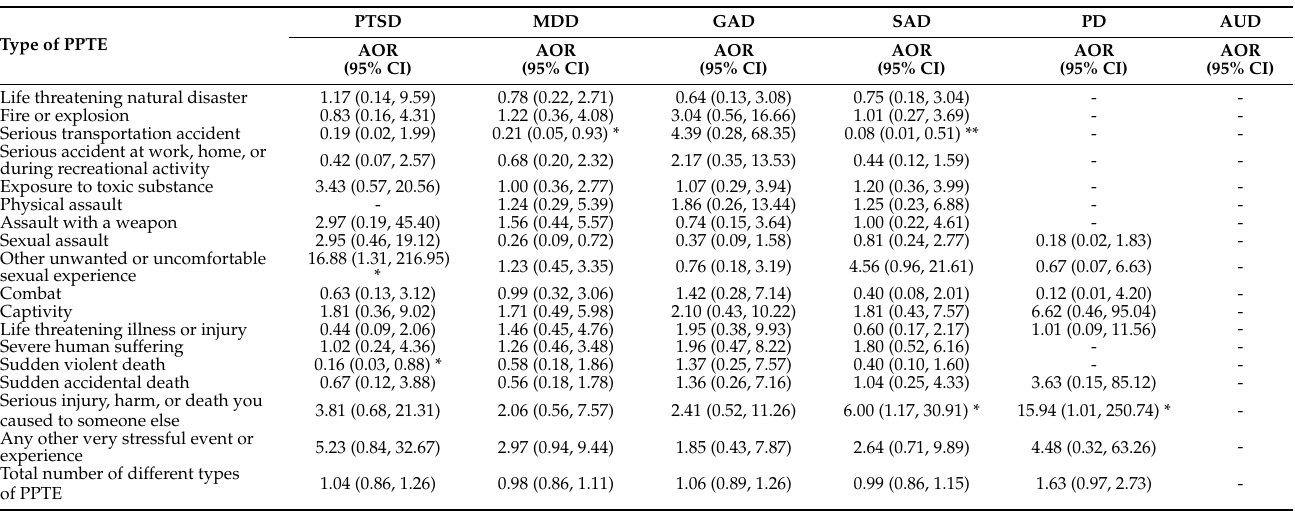
Table 7. Associations Between Potentially Psychologically Traumatic Events (PPTEs) Exposure and Screening Positive for Mental Disorders, Conservation and Protection (C&P) Sample (Adjusted for